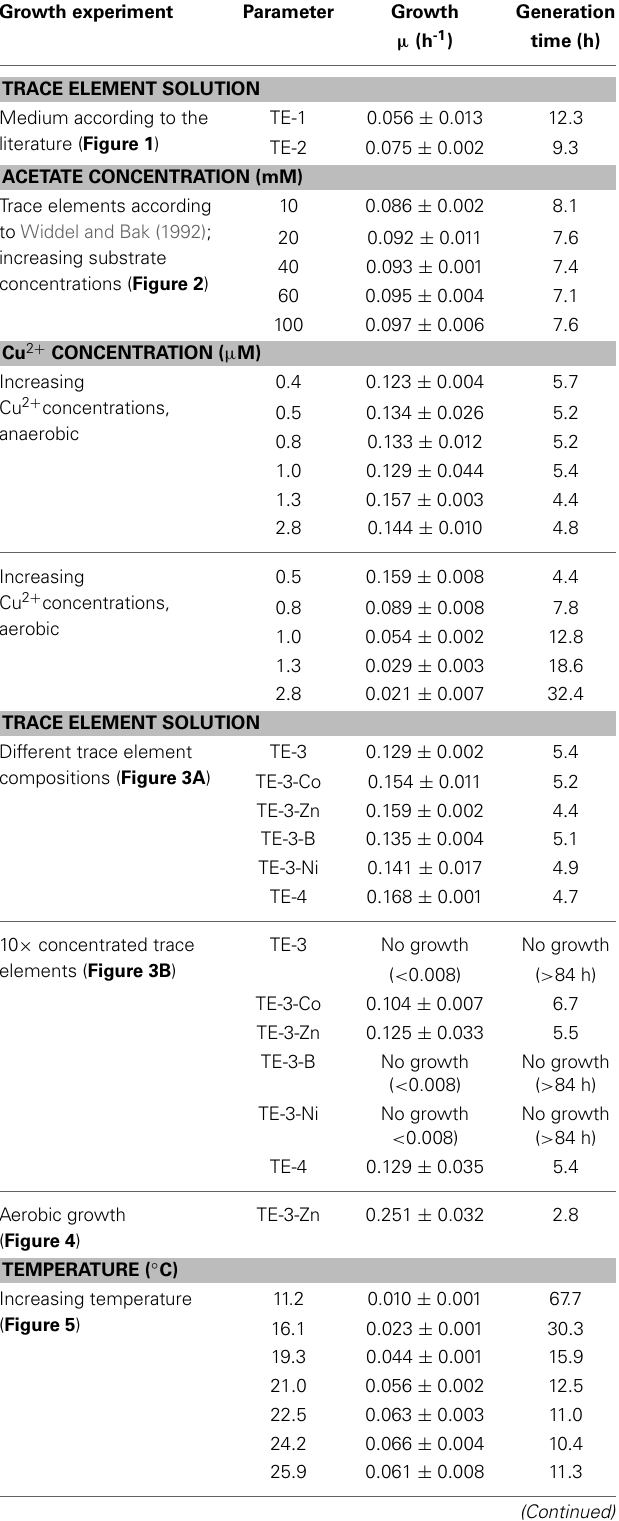
Table 3 | Growth characteristics of Paracoccus denitrificans Pd1222, grown in batch cultures under anoxic, denitrifying conditions unless otherwise